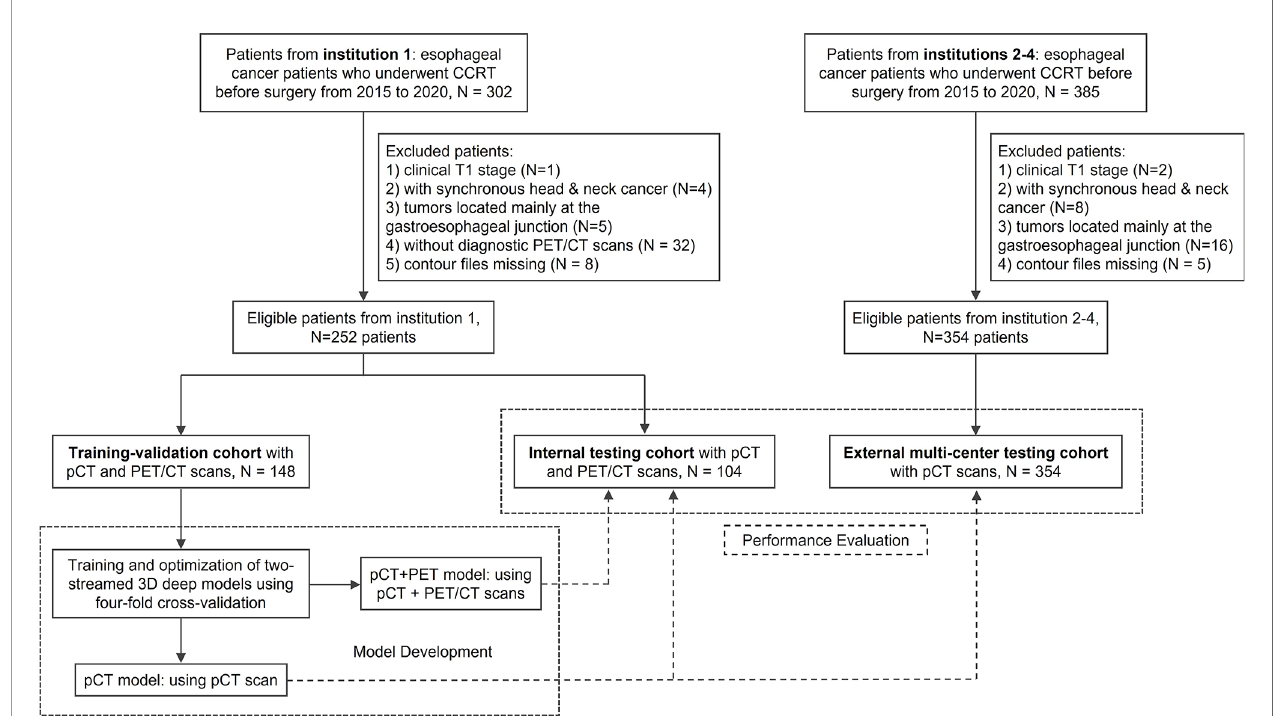
FIGURE 1 | Study fl ow diagram of esophageal gross tumor volume (GTV) segmentation in a multi-institutional setup. CCRT, concurrent chemoradiation therapy; pCT, treatment planning